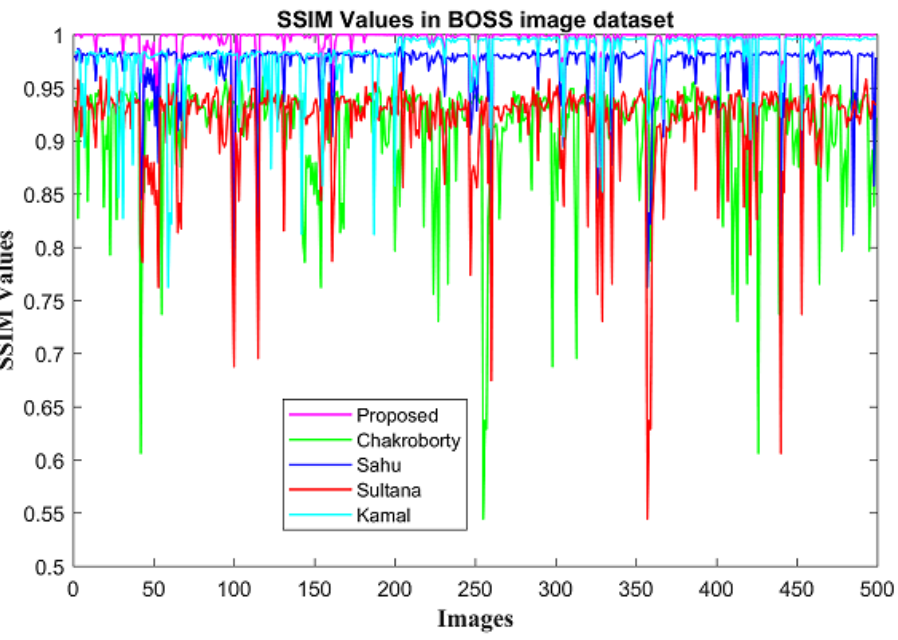
Figure 9. Comparing SSIM values of BOSS image dataset in different schemes. The figure states that the proposed scheme has the highest SSIM value.